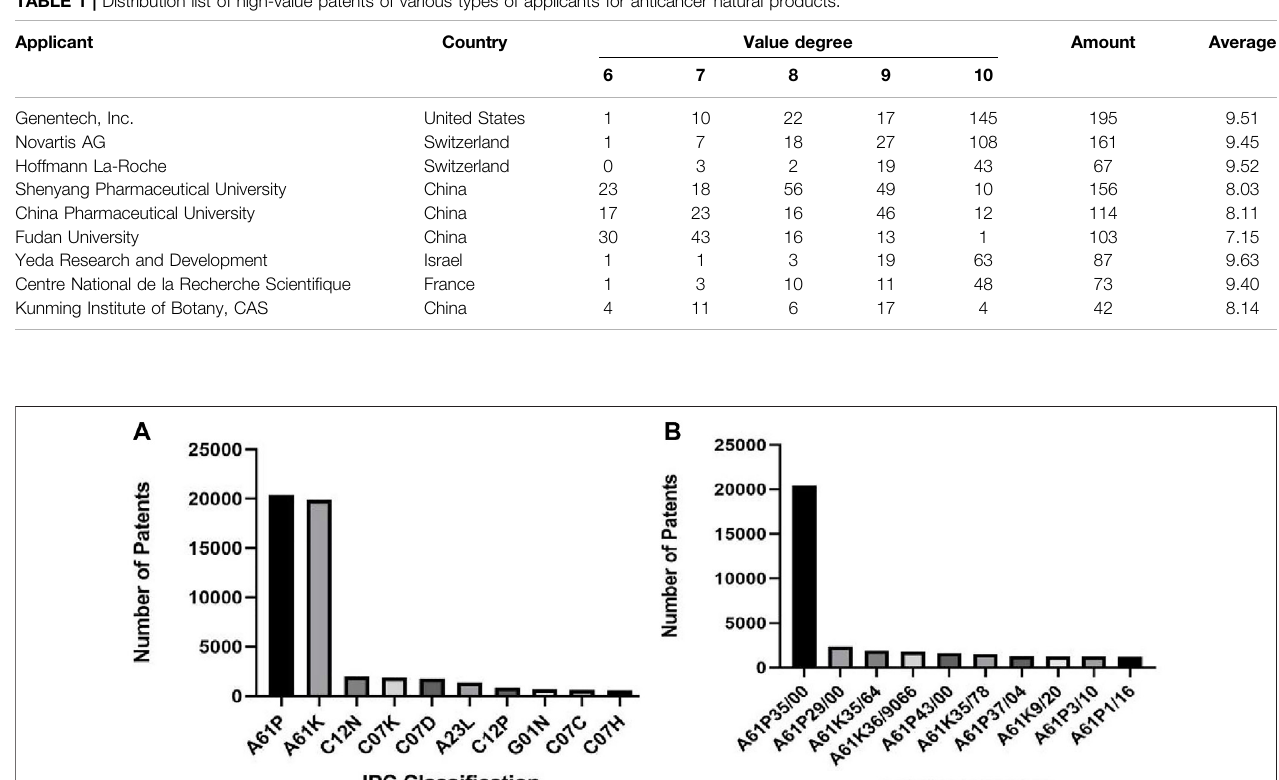
Frontiers in Pharmacology |